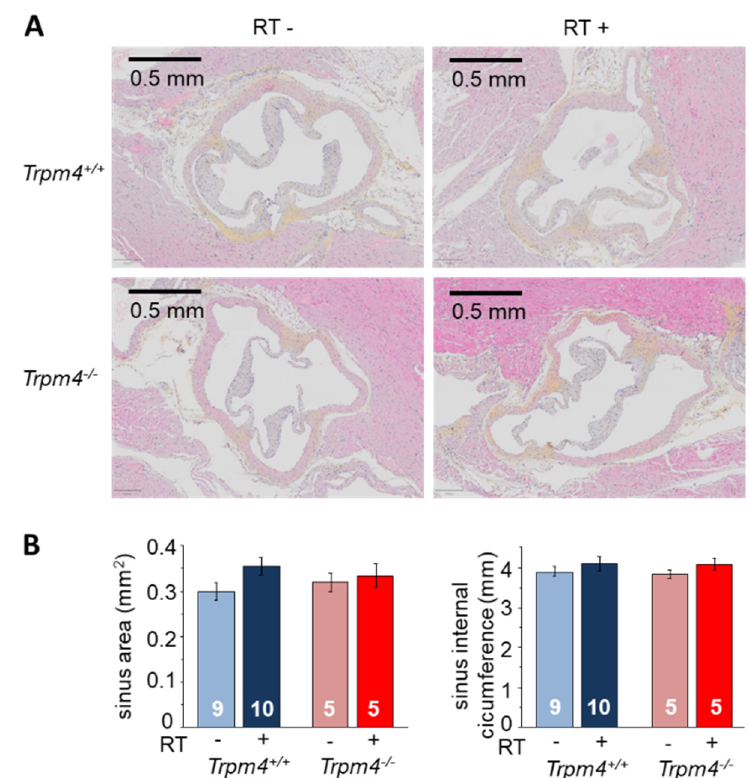
Figure 5. Morphological remodeling after irradiation: sinus remodeling in the transversal axis. ( A ) Histological slice performed at 5 months post-treatment in the transversal axis (3 µ m thickness) of the aortic valve representative for each group. Slices were stained with hematoxylin, eosin, and saffron (HES) to reveal cell nuclei (blue) cytoplasm (pink) as well as collagen fibers (yellow). ( B ) The sinus area ( left ) as well as the sinus internal circumference ( right ) was measured for each mouse. Histograms indicate the mean ± S.E.M for each